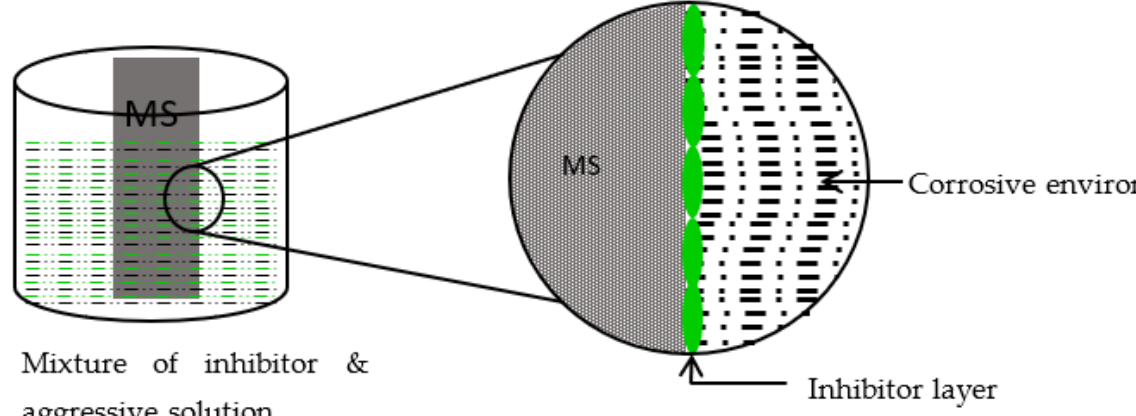
Figure 17. Schematic diagram for the mechanism of inhibition.